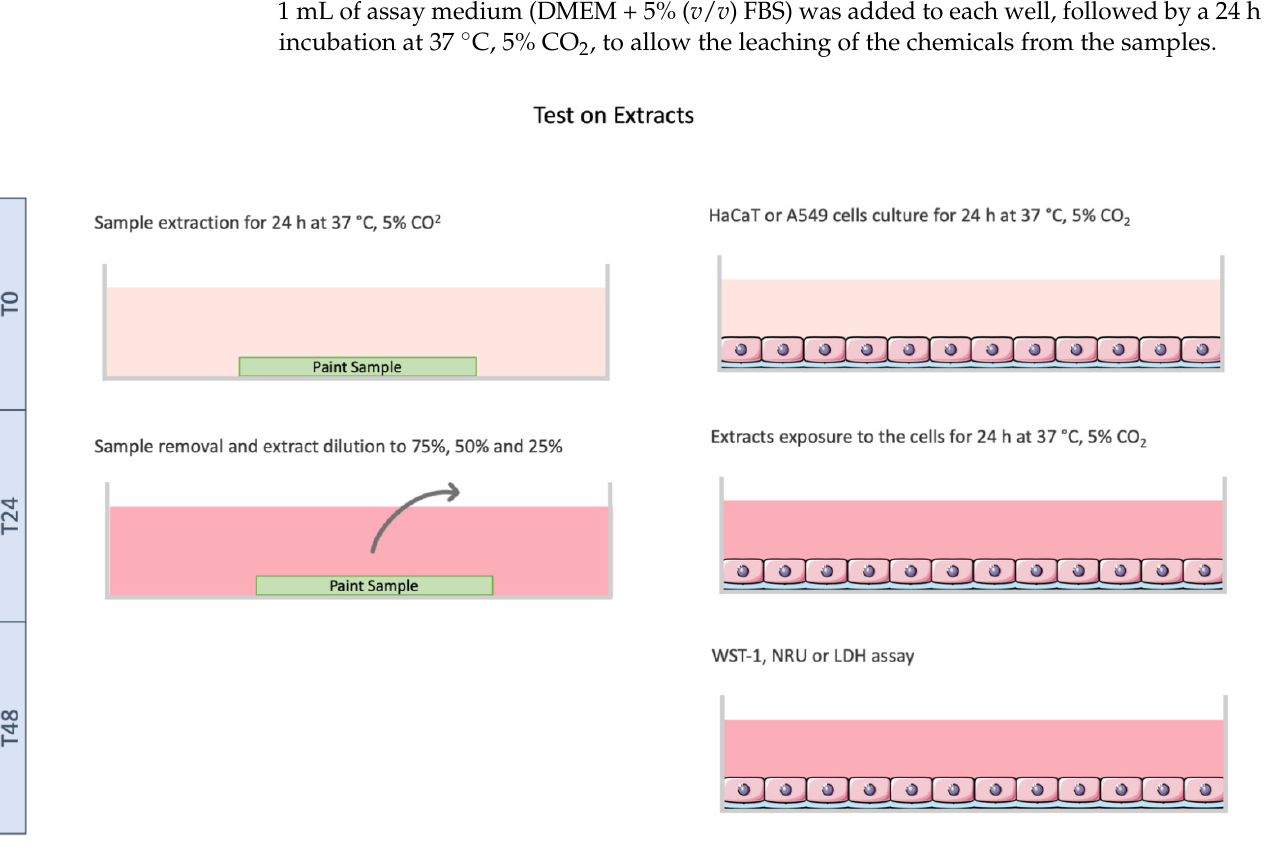
Figure 2. Schematic representation of test on extracts performed with HaCaT and A549 cell lines. Cells were exposed to the extracts for 24h followed by cytotoxicity assays. Image not to scale. Simultaneously, cells, both HaCaT and A549, were seeded in 96-well plates (1.0 × 10 5 cells/mL) and incubated for 24 h at 37 ◦ C, 5% CO 2 in a humidified atmosphere to enable cell adhesion.